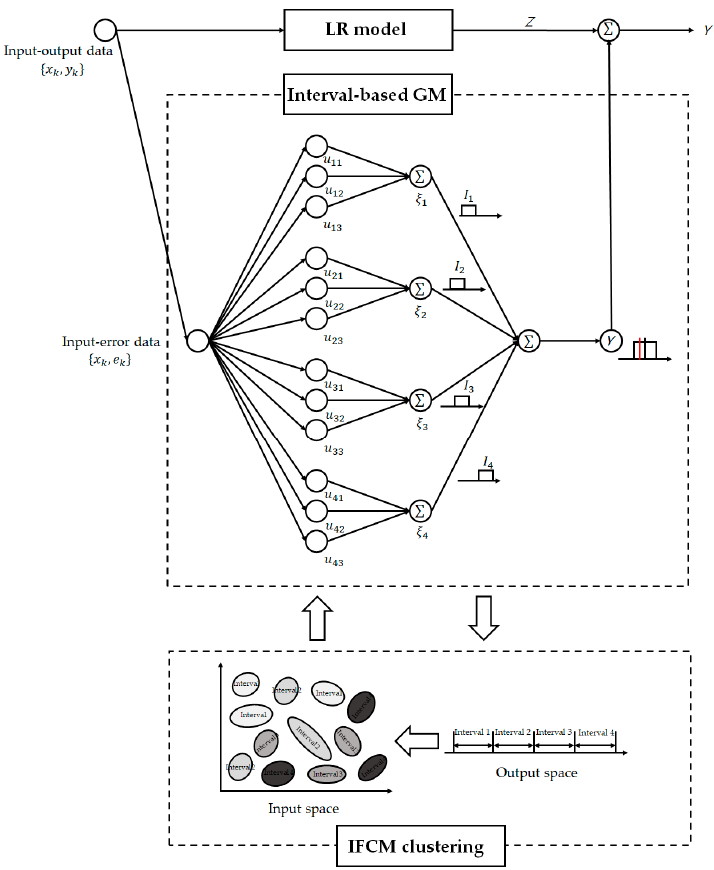
Figure 5. Architecture of interval-based incremental granular model (IGM) based on interval-based fuzzy c-means (IFCM) clustering.